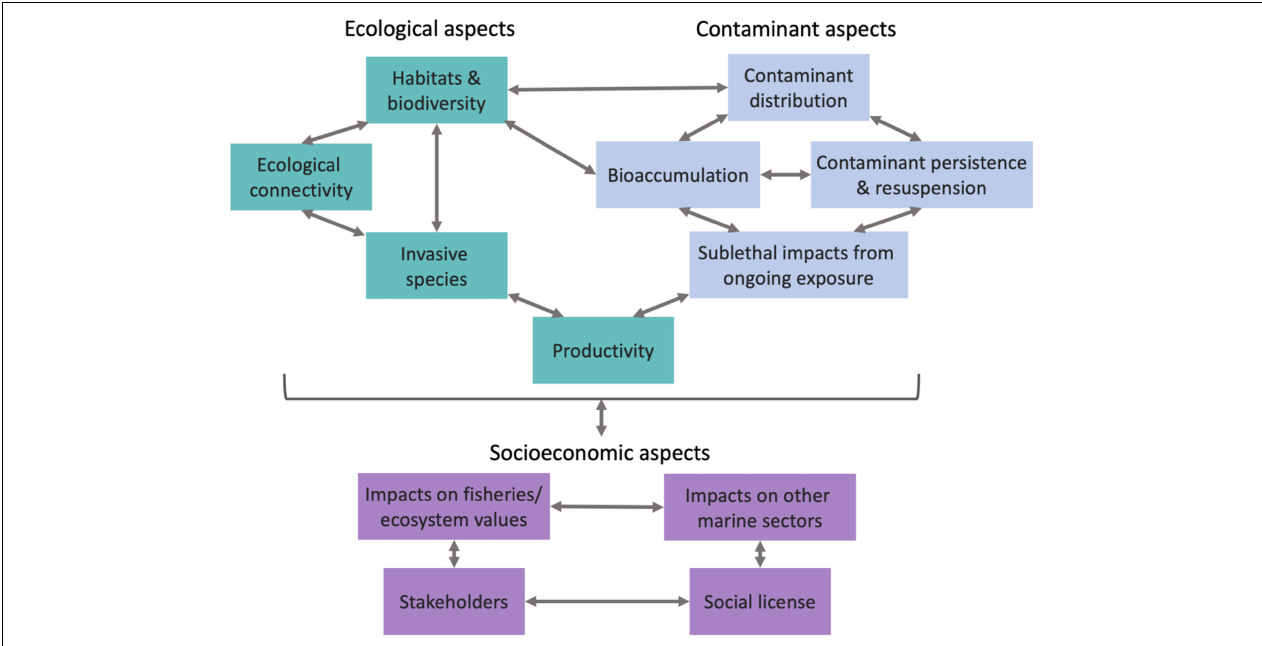
FIGURE 2 | Summary of connections between different research elements needed to consider risk and impacts for decommissioning options. Boxes and arrows are colour coded as: ecological aspects (green), contaminant aspects (blue) and socioeconomic aspects